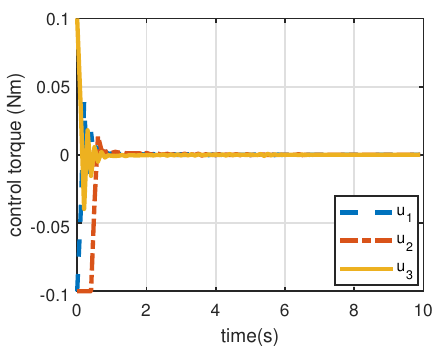
Figure 11. The evolution of control